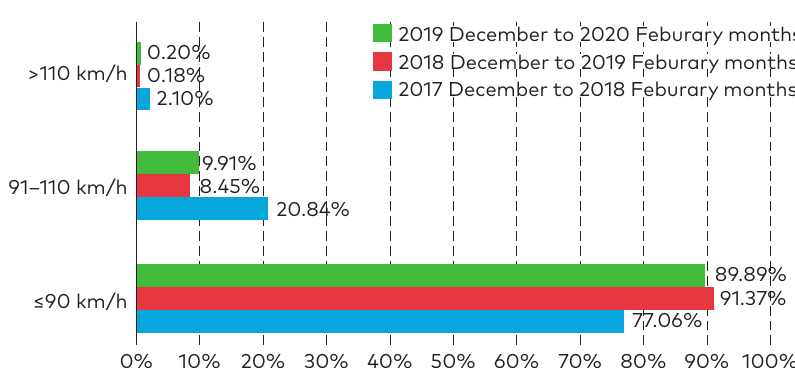
Figure 6. Comparison of speed data recorded by the average speed enforcement systems in the study